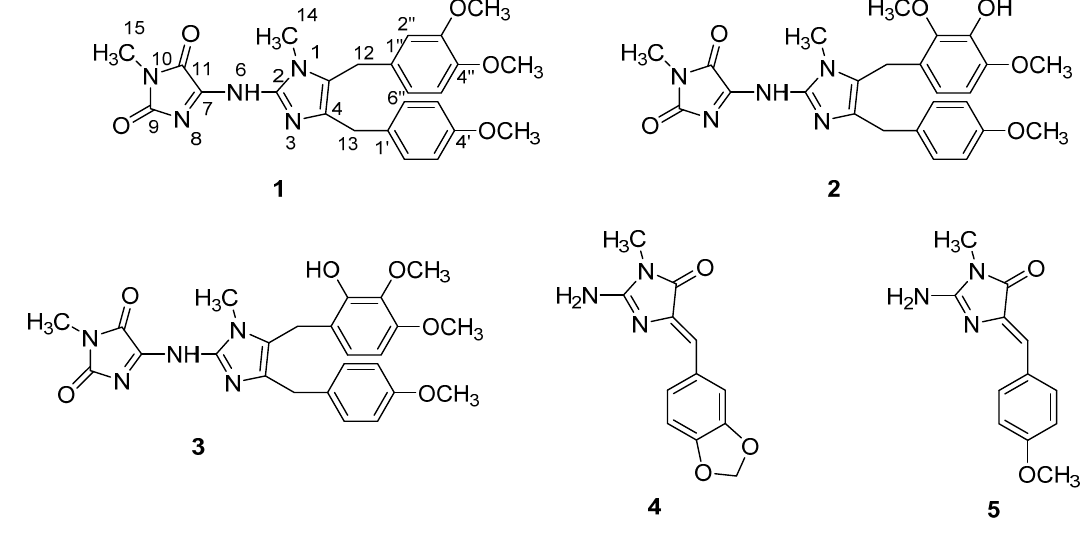
Figure 1. Structures of compounds 1 – 5 .